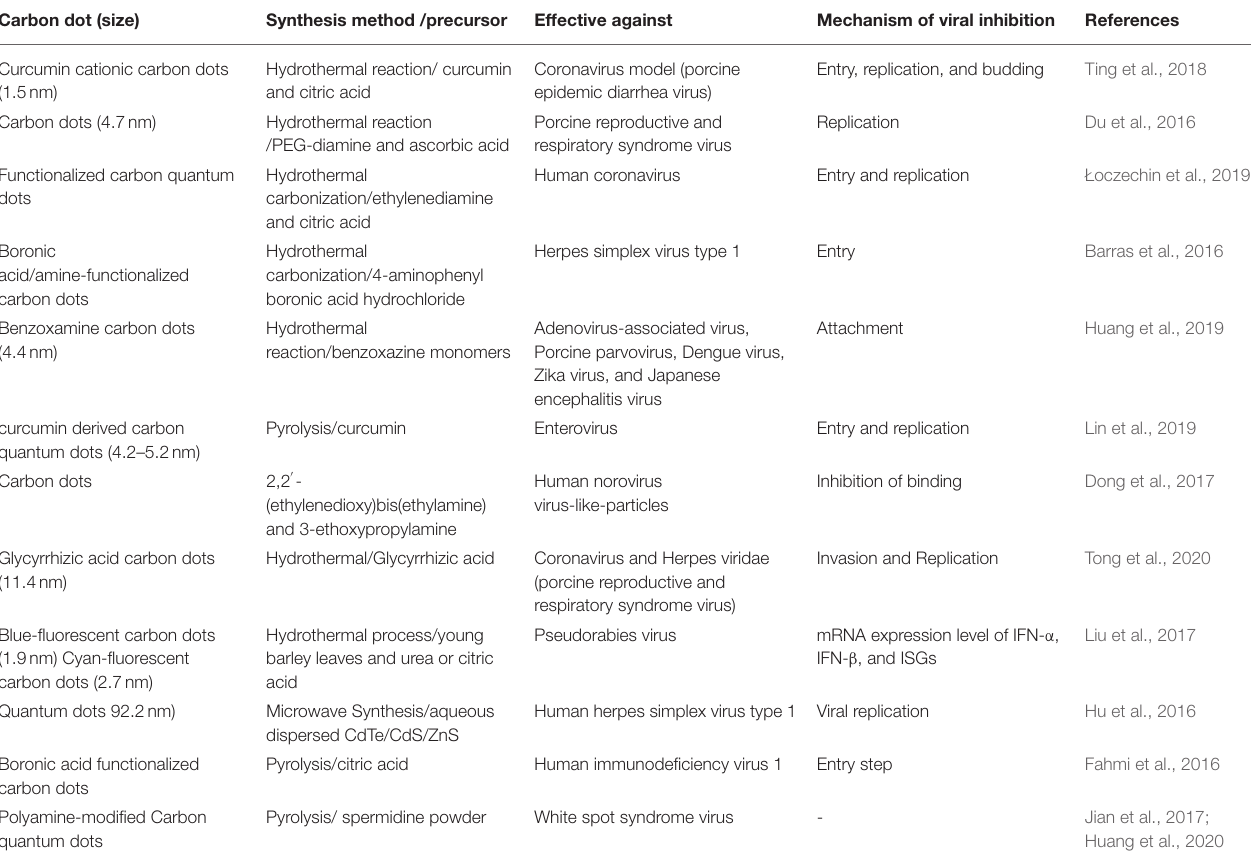
TABLE 1 | Antiviral carbon